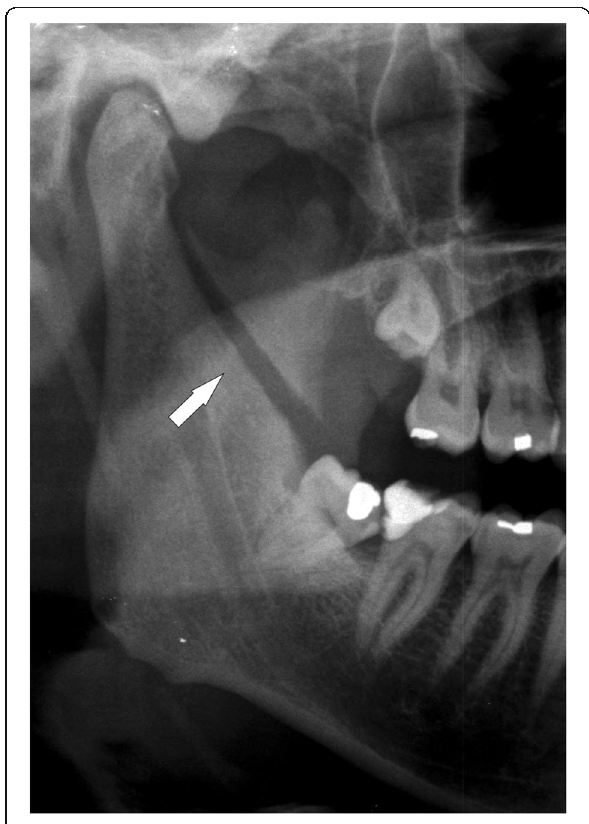
Fig. 11 Coronoid process fracture lateral to the deepest central point of the sigmoid notch. Cropped panoramic radiograph showing a displaced fracture of the right coronoid process (arrow). The temporal muscle elevates the bone fragment